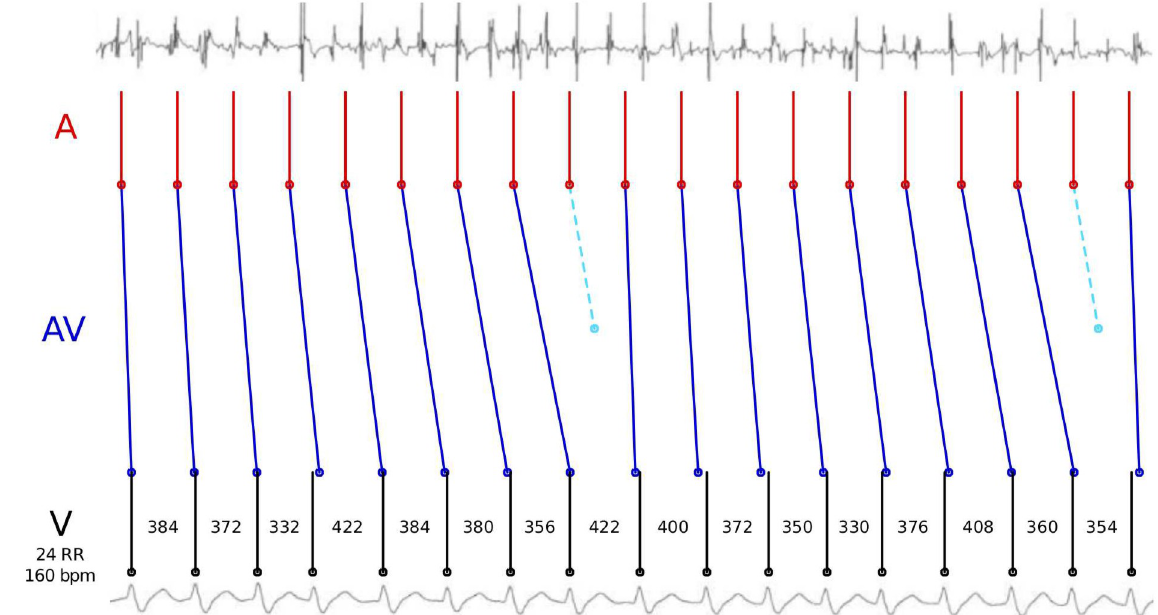
Fig 8. Example of an atrial fibrillation input that is misclassified due to pseudo-regularization.